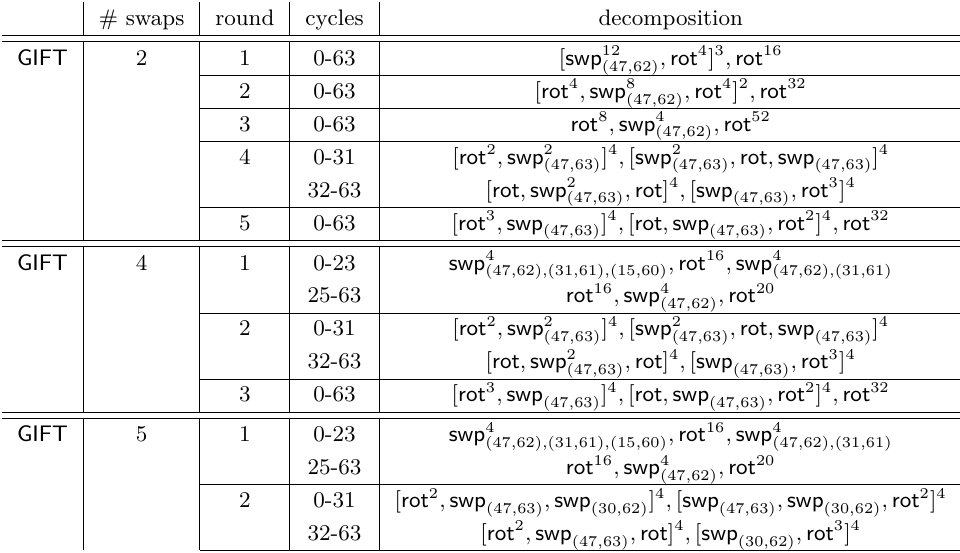
Table 10: Cycle vs. Mux trade-off for